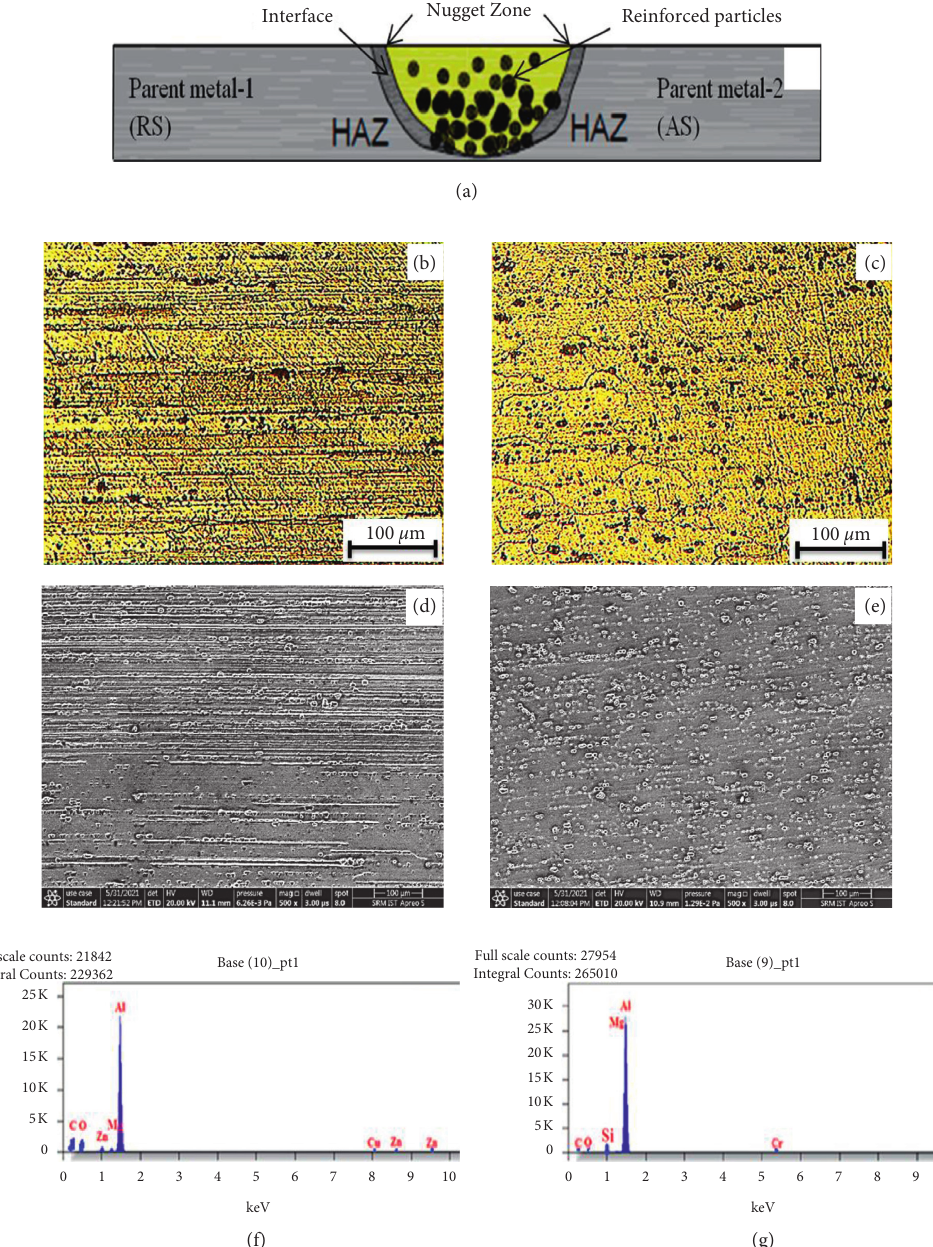
Figure 7: (a) Microstructural location, optical microimages of base alloys (b) AA7075-T651 and (c) AA6061-T6, FESEM micrographs of (d) AA7075-T651 and (e) AA6061-T6, and EDS of (f) AA7075-T651 and (g)